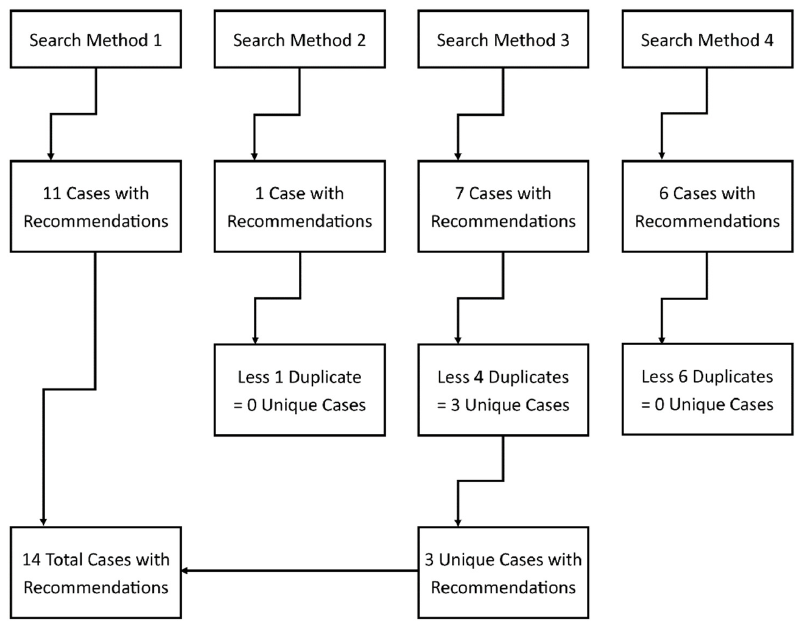
Figure 1. Case identification across the four search